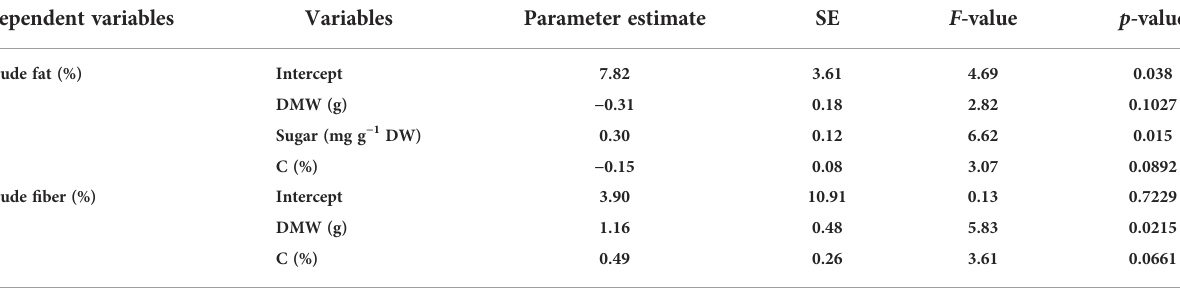
TABLE 3 Multivariate linear regression of crude fat and crude fi ber contents against growth and physiological parameters in alfalfa ( Medicago sativa L.) seedlings. Dependent variables Variables Parameter